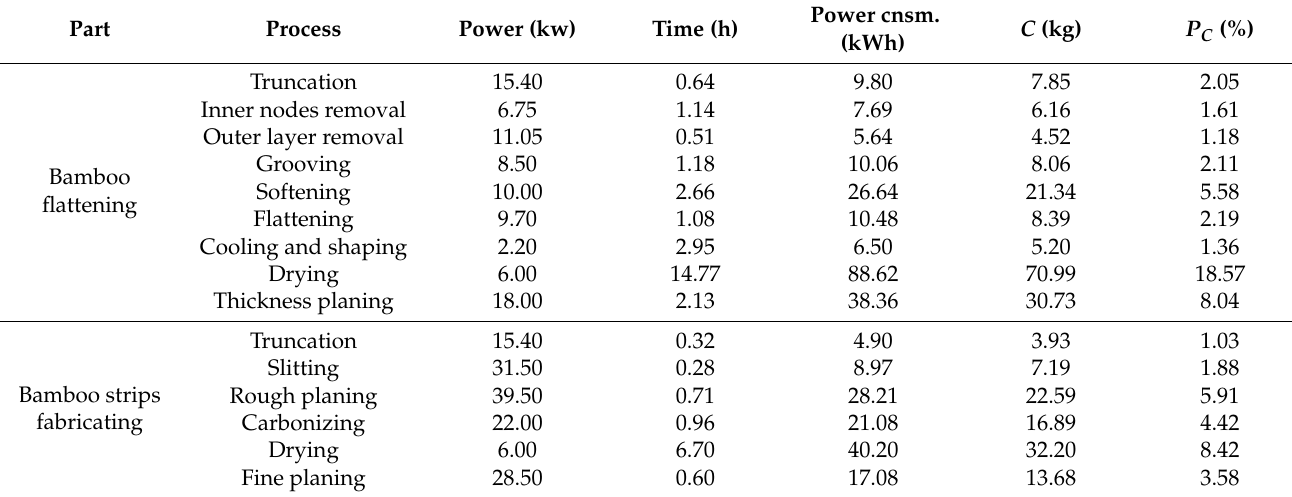
Table 4. CO 2 emissions for the production of 1 t of